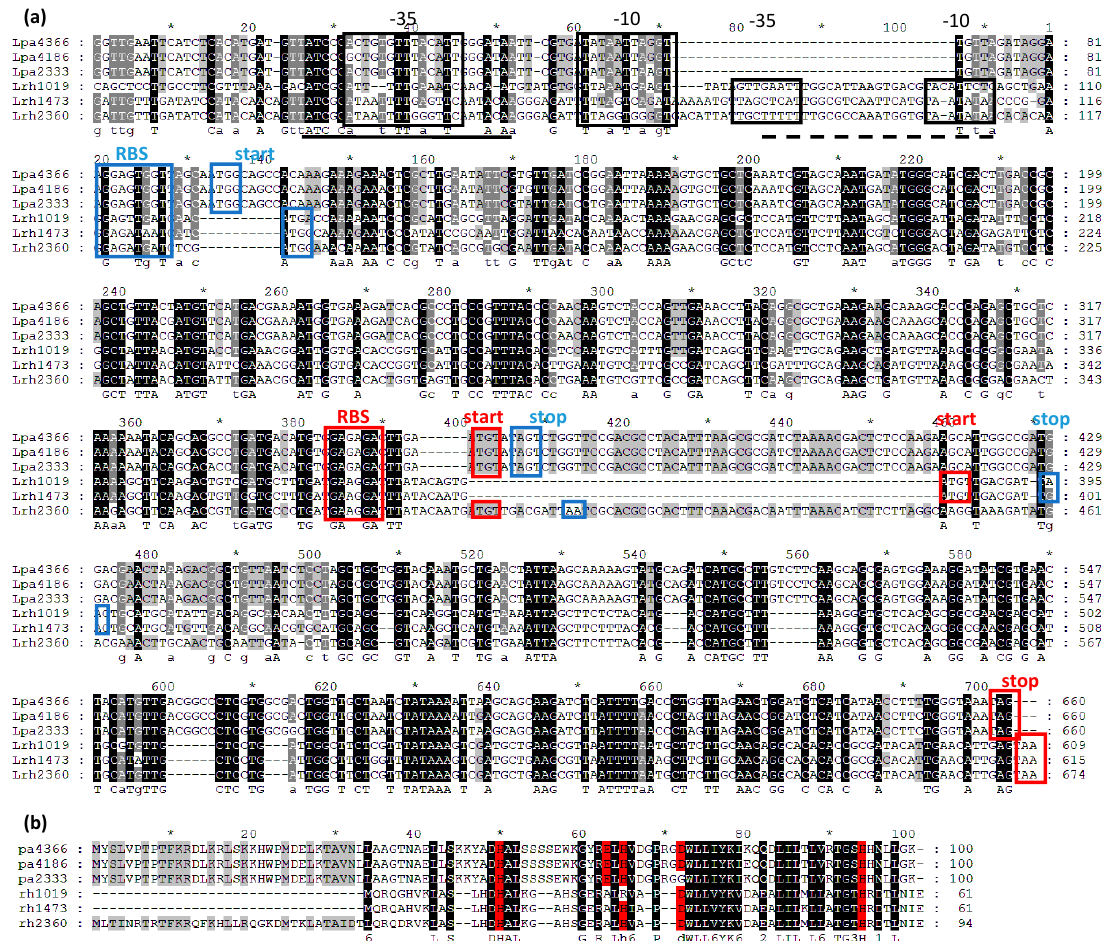
Figure 1 . ( a ) Multiple alignment of nucleotide sequences including din J- yaf Q operons and their promoter regions from all the Lactobacillus strains used in this work. Predicted promoter regions are boxed in black and palindromic sequence are indicated by black line for L. paracasei sequences and by dashed black line for L. rhamnosus sequences. The ribosome binding site (RBS), the start codon (start) and the stop codon (stop) are boxed in blue and red for din J and yaf Q sequences, respectively. ( b ) Multiple alignment of amino acid YafQ sequences from all the Lactobacillus strains used in this work. Catalytic residues, as identified in E. coli , are highlight in red.